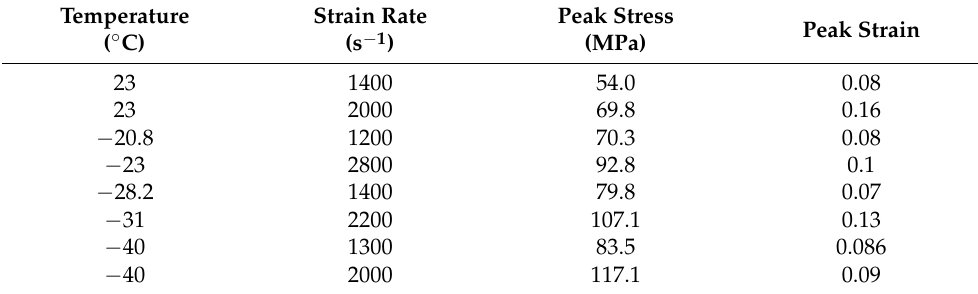
Figure 8. The stress–strain curves of reinforced Al/PTFE specimens at the same strain rate and different temperatures ( a ) 1400 s − 1 ; ( b ) 2000 s − 1 . Table 3. Peak stress and peak strain corresponding to different strain rates at low